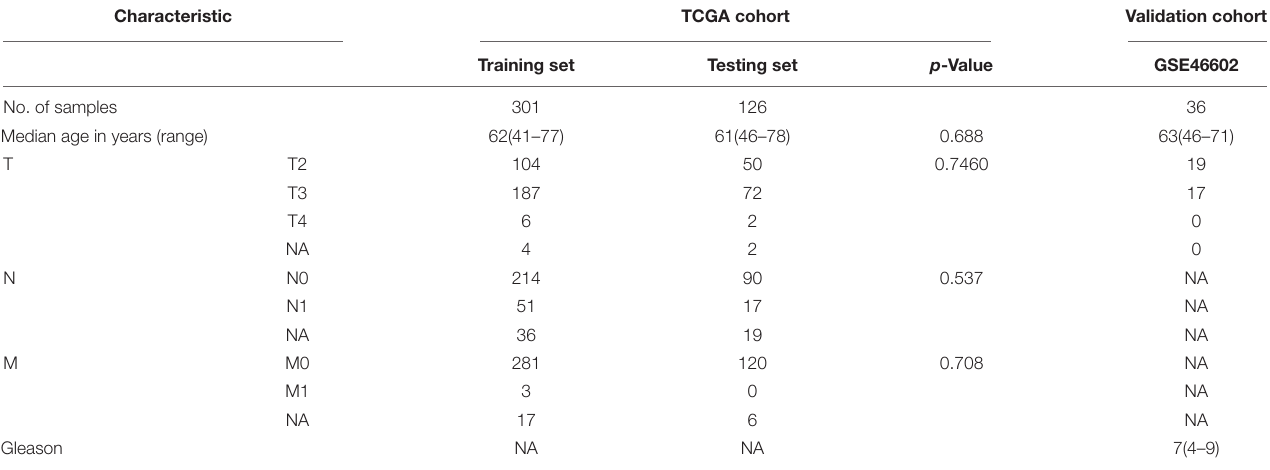
FIGURE 2 | Construction of co-expression modules using the WGCNA package. (A) Cluster dendrogram of genes in GSE46602 dataset. Each branch in the figure represents one gene, and every color represents one co-expression module. (B) Heatmap of the correlation between module eigengenes and the disease status of PCa. (C) Scatter plot of module eigengenes in the brown module. TABLE 1 | Clinical characteristics of prostate cancer patients in different